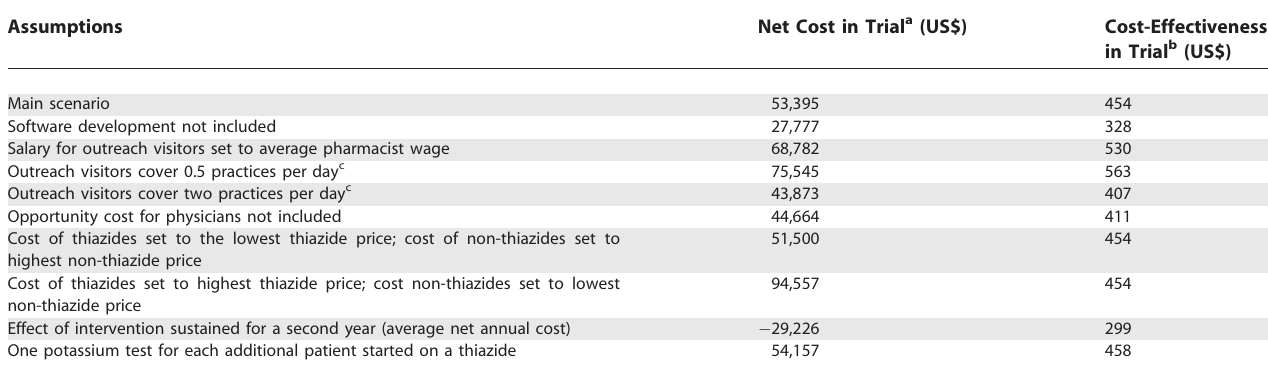
Table 5. Univariate Sensitivity Analyses Assumptions